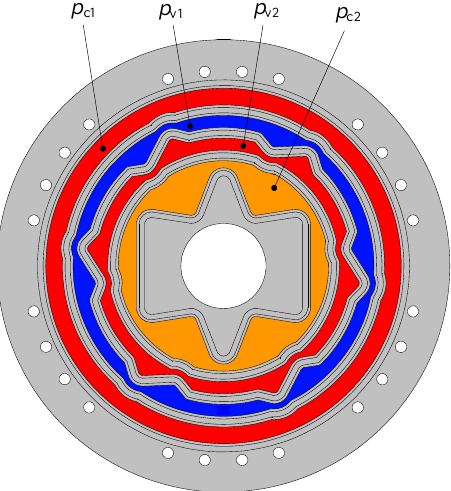
Figure 3: The geometry of the compensation and vane actuation supply pressure volumes, which are between the inner and outer